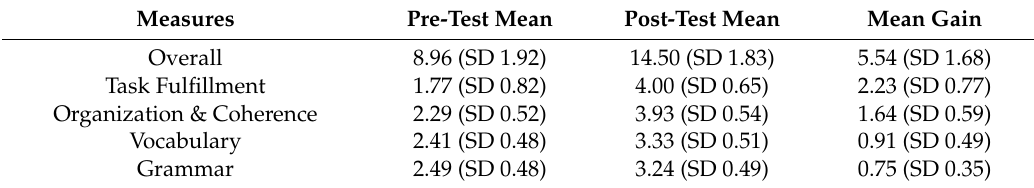
Table 1. Experimental group ( n = 35) overall and component pre-test to post-test mean scores, mean gain scores, and standard deviations (SD).